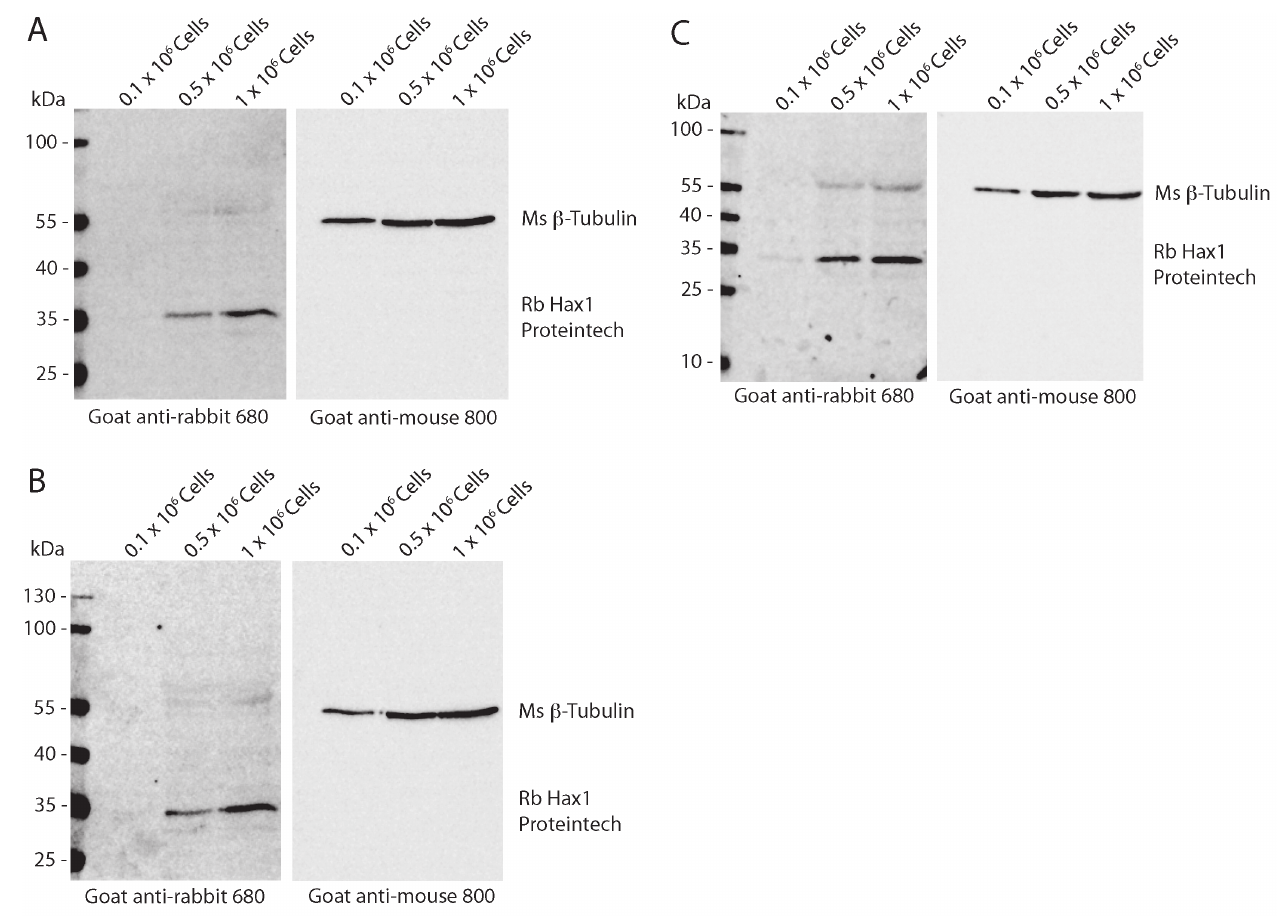
Figure 2. Detection of Hax1 in differentiated PLB-985 cells using a rabbit anti-Hax1 antibody. Western blot analysis of differentiated PLB-985 cell lysates from 0.1 × 10 6 , 0.5 × 10 6 , and 1 × 10 6 cells from three independent replicates. Mouse anti-tubulin (beta-) is used as a loading control and can be seen present at a relative mobility of 55 kDa. Rabbit anti-Hax1 detects a band at a relative mobility of 35 kDa as predicted. Hax1 can be detected in densities as low as 0.1 × 10 6 cells ( C